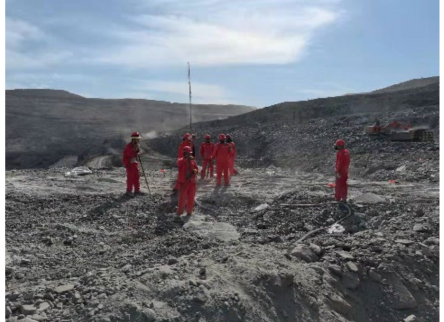
Figure 7. Site construction process.